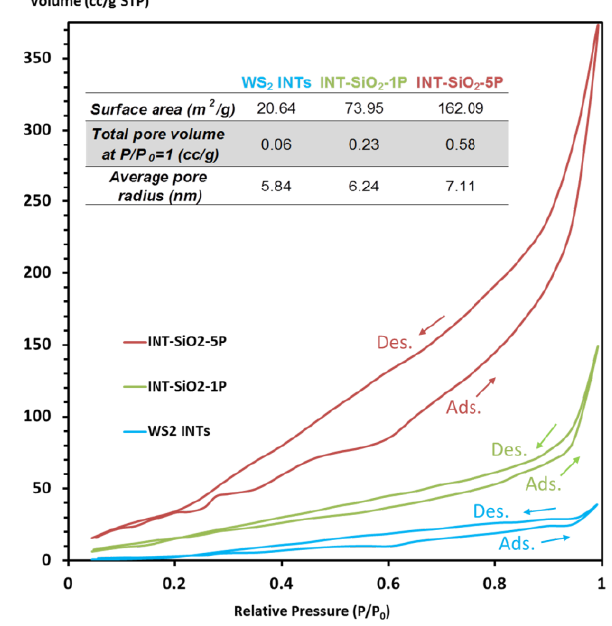
Figure 9. BET N 2 adsorption-desorption isotherms and data for WS 2 INTs, INT-SiO 2 -1P and INT-SiO 2 -5P.